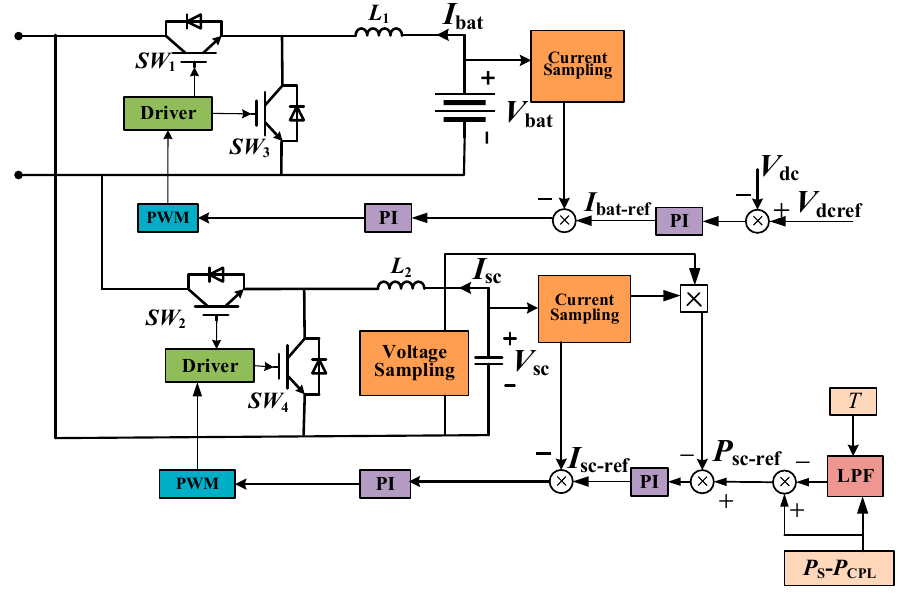
Figure 10. Control block diagram of HESS converters.